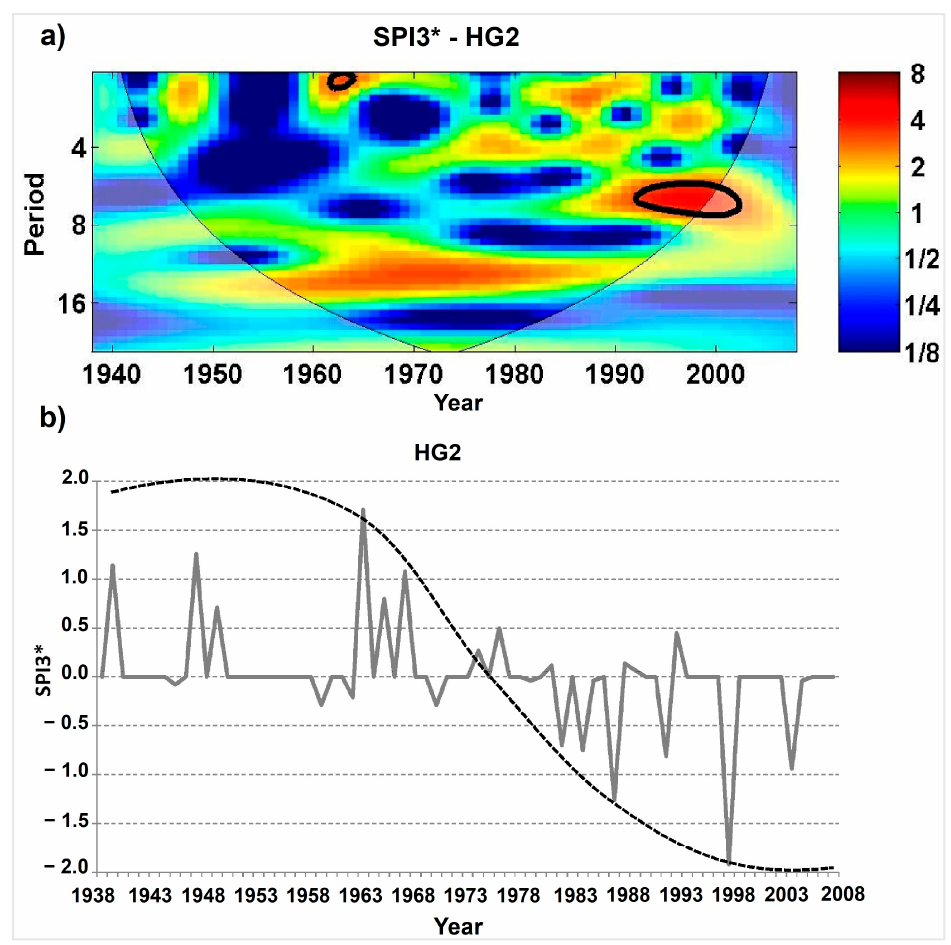
Figure 4. Same as Figure 3 for HG2.